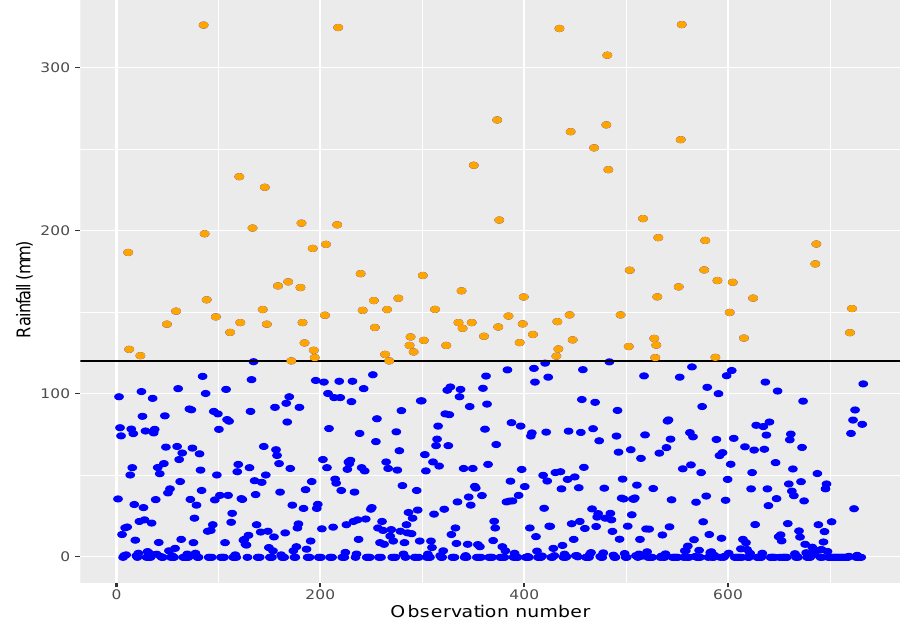
Figure 6. Plot of exceedances.